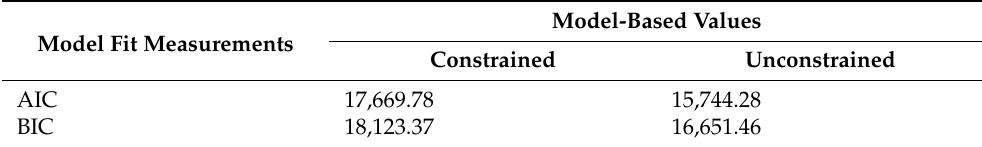
Table 4. Model fitness of the multi-group